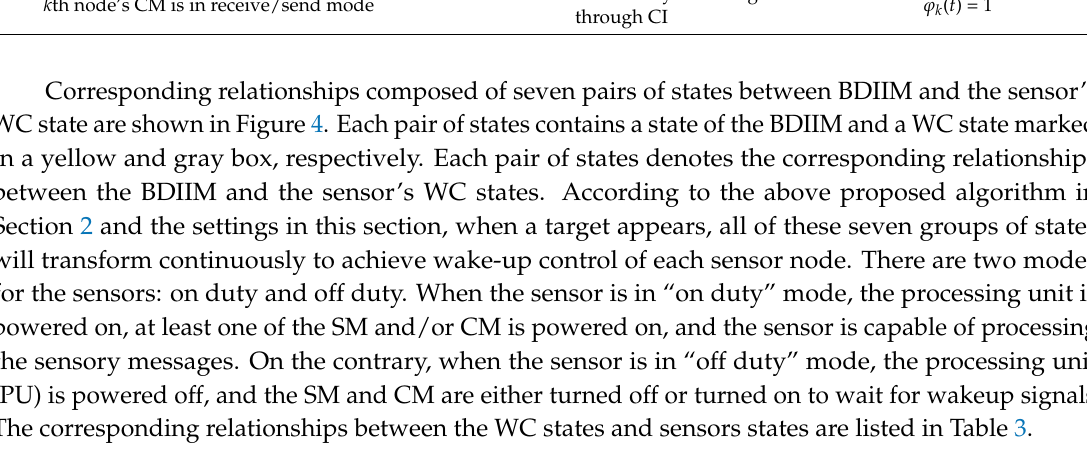
Table 3. The corresponding relationships between the WC states and sensor